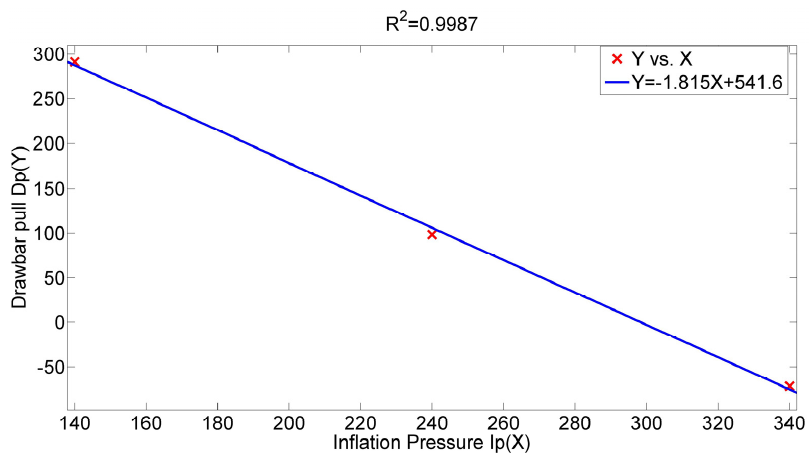
Figure 6. Drawbar pull with respect to inflation pressure.